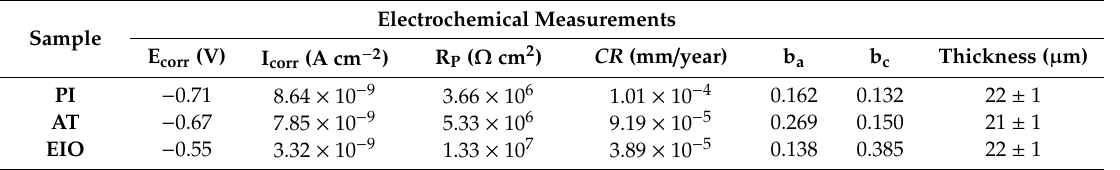
Table 3. Electrochemical parameters derived from Tafel plots of the coatings in the saline solution after 30 days